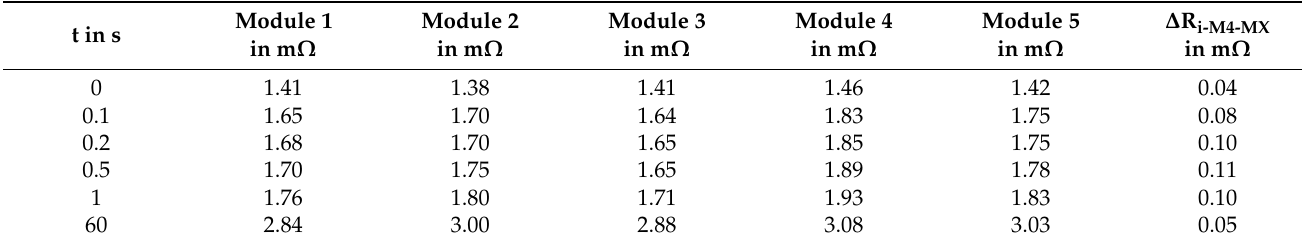
Table 4. Comparison of different SOC working points at 0.5 s in the relaxation phase, internal resistances are normalized to the best module.